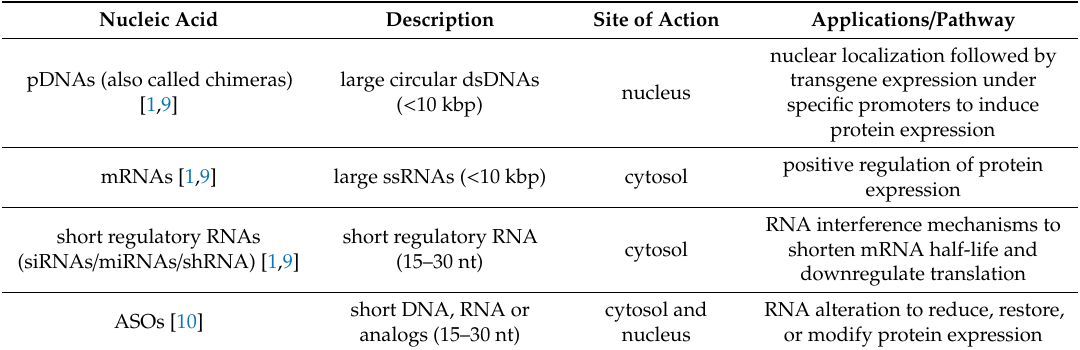
Table 1. The major types of NAs used in gene delivery applications and their specific